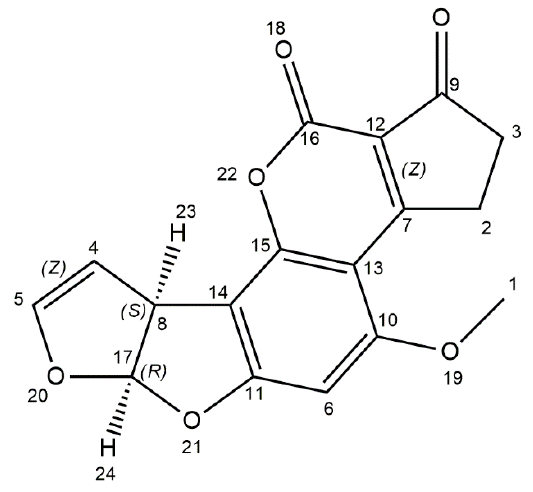
Figure 1. Chemical structure of aflatoxin B1 (structure generated from InChI code available on https://pubchem.ncbi.nlm.nih.gov/) (accessed on 16 August 2020).